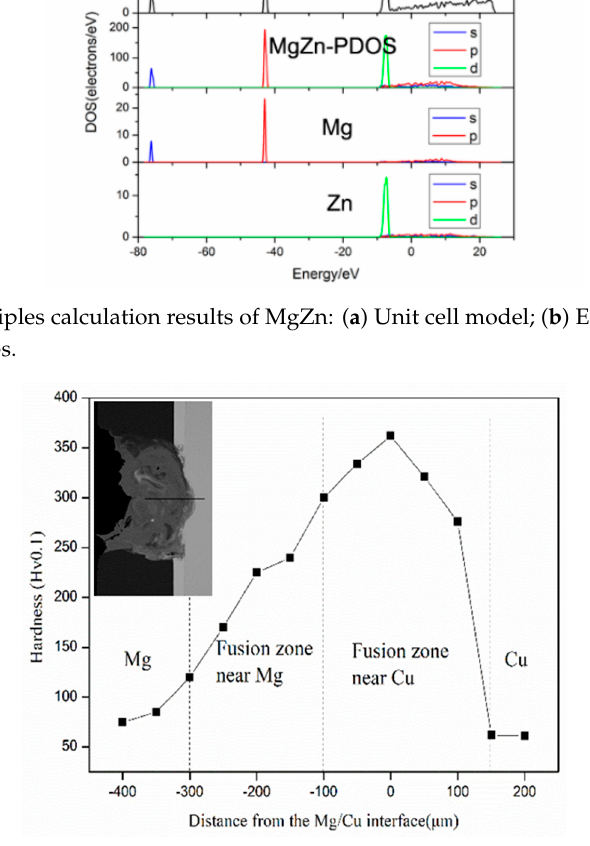
Figure 6. First-principles calculation results of MgZn: ( a ) Unit cell model; ( b ) Electron density map; ( c ) State density maps.